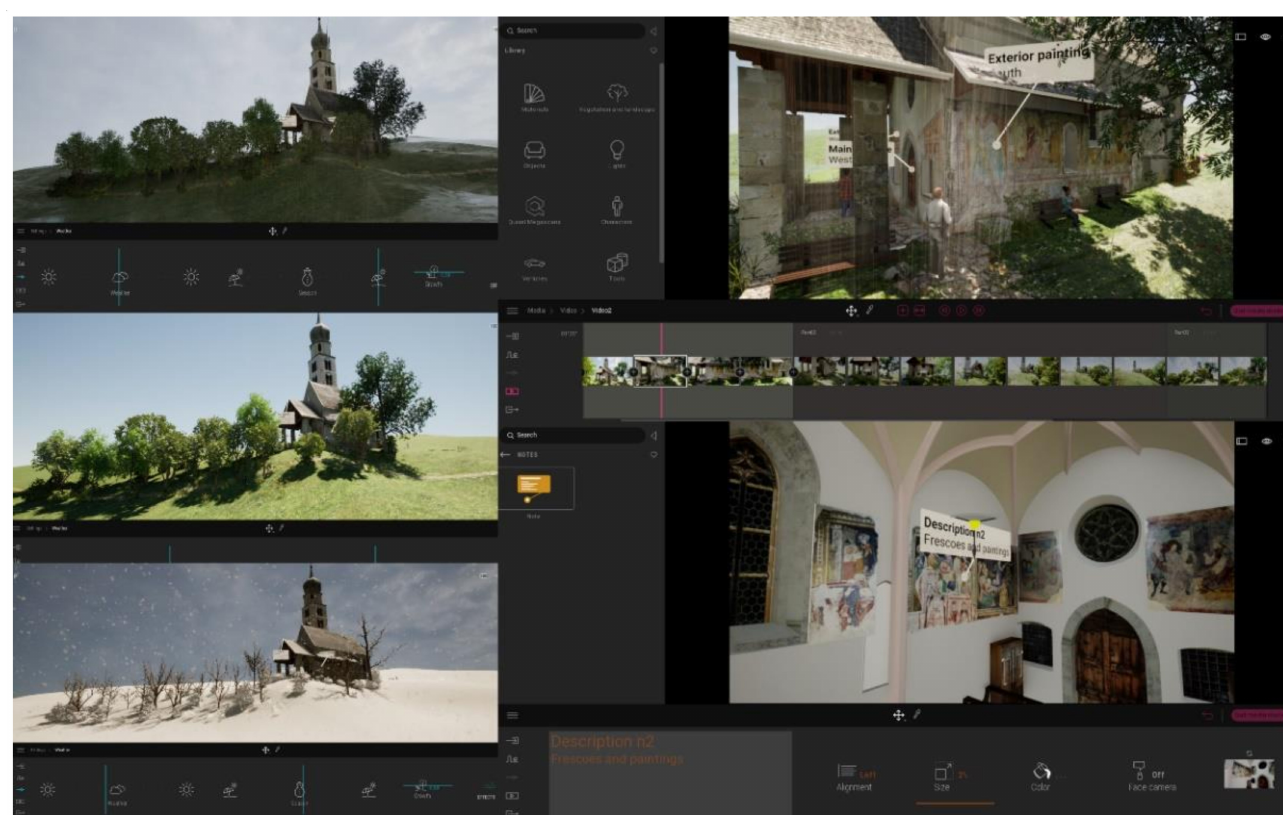
Figure 10. The level of virtual interactivity of the VR project in Twinmotion allows the user to simulate environmental climates, seasons, lighting, creating 3D animation and discovering information related to the XR objects imported into the scene, such as frescoes and